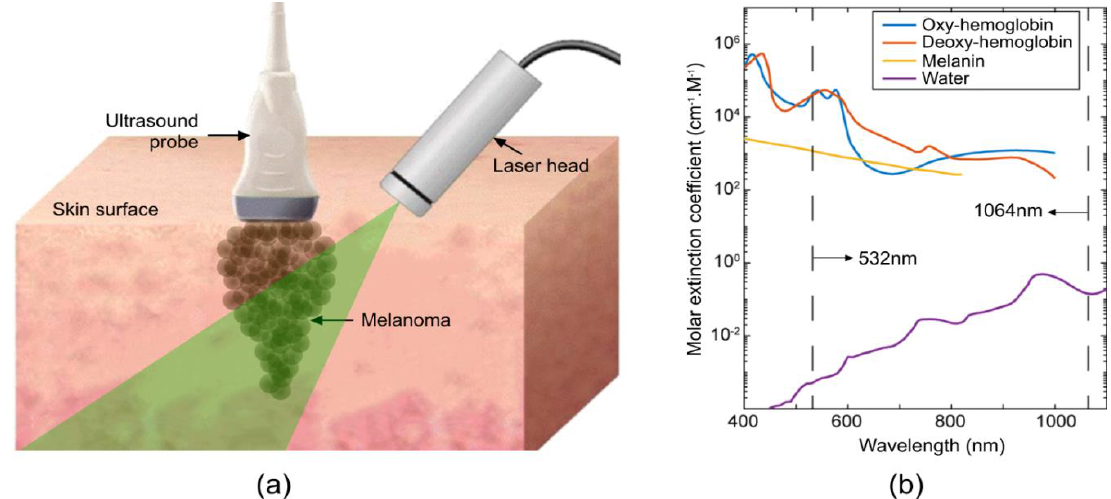
Figure 1. Principle of photoacoustic imaging. ( a ) Schematic of photoacoustic imaging setup for the acquisition of images from swine skin. ( b ) Optical absorption spectrum for most abundant photoacoustic absorbers in the skin with dashed lines showing wavelengths used in this study. Left: 532 nm; right: 1064 nm.